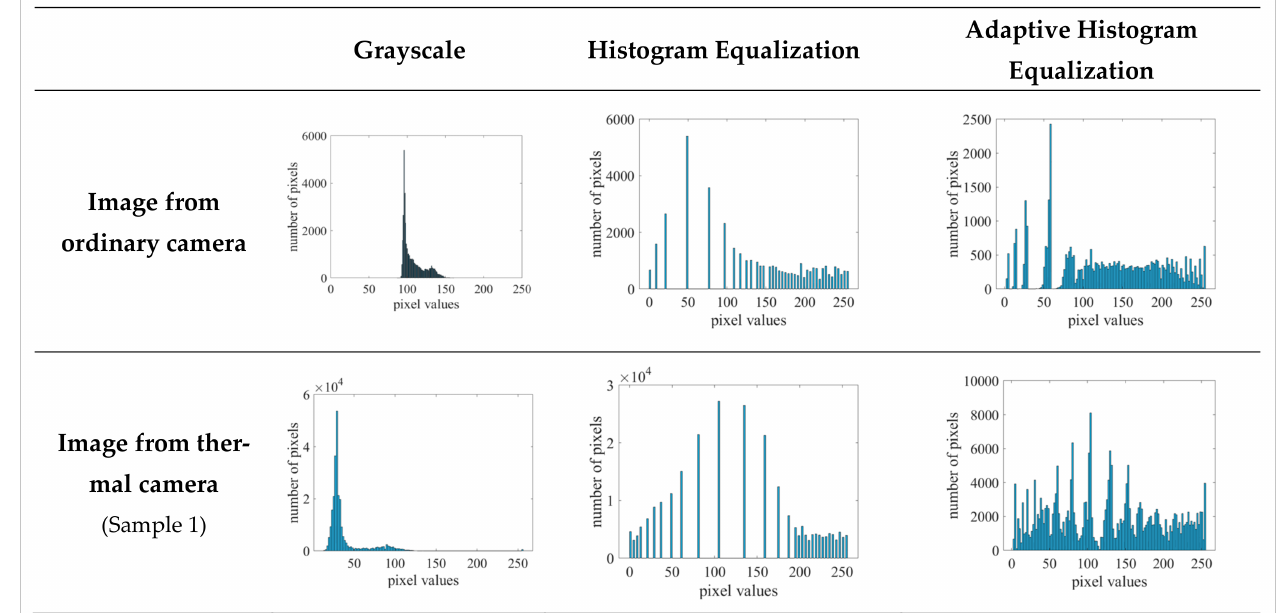
Figure 12. Histogram representation of the processed sample images.